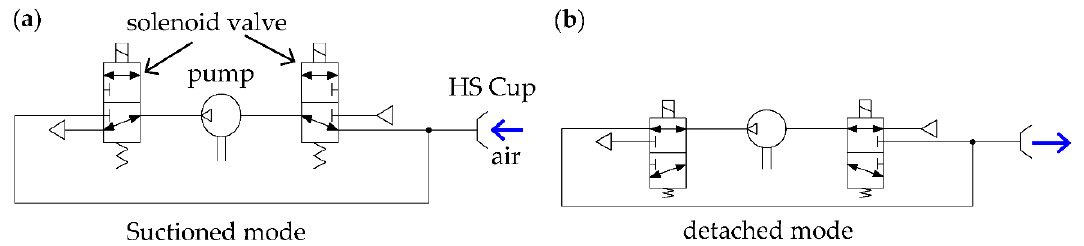
Figure 5. Pneumatic circuit to generate two different modes with a positive pressure pump: ( a ) suctioned mode; ( b ) detached mode.